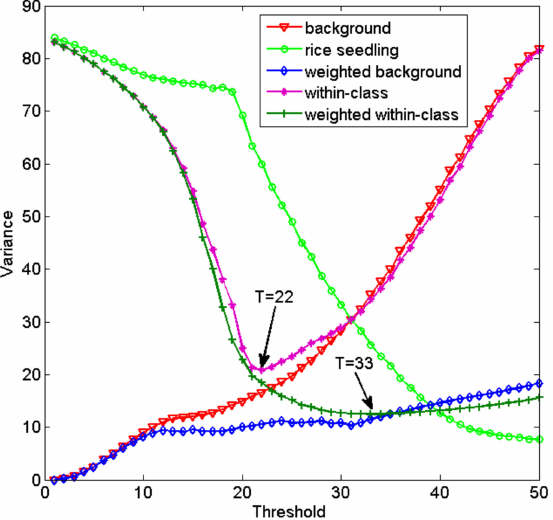
Figure 9. Curves of before and after weighted background variance and within-class variance of the image given in Figure